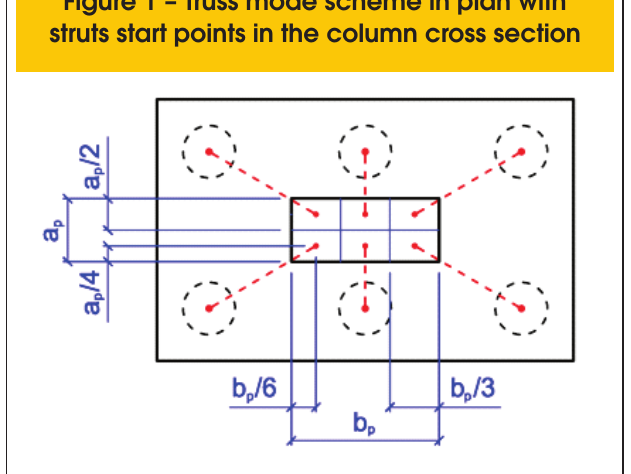
Figure 1 – Truss mode scheme in plan with struts start points in the column cross